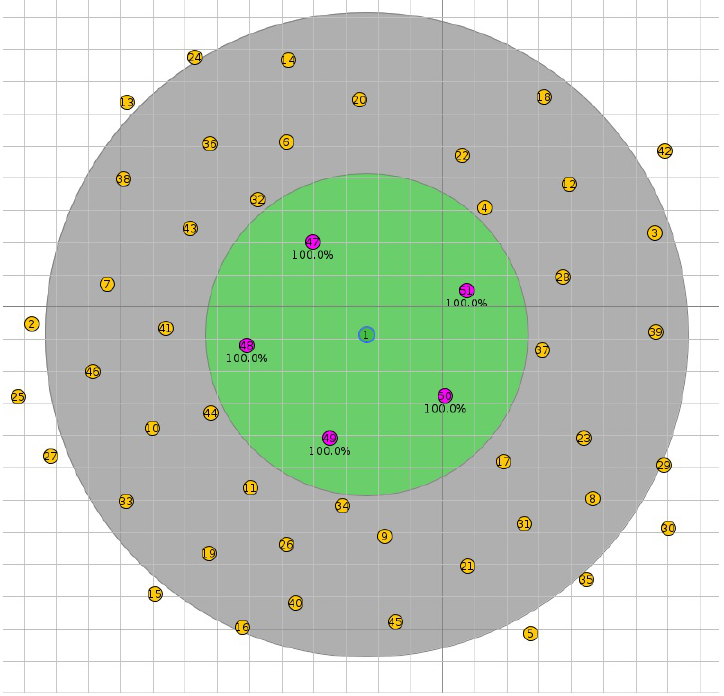
Figure 2. Bottleneck topology with 50 randomly deployed